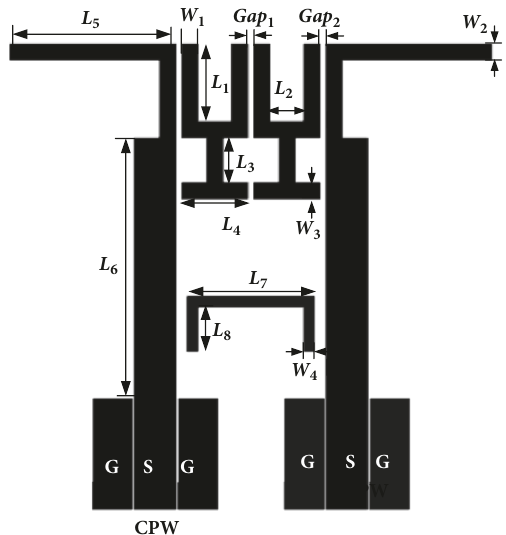
Figure 1: Schematic views of the proposed dual-band